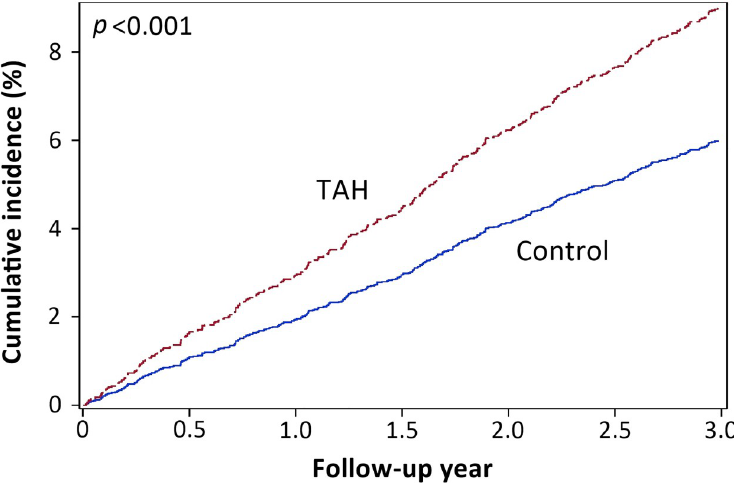
Fig 2. Cumulative incidence of fracture events using Kaplan–Meier estimator. Thiazide-assssociated hyponatremia (TAH) patients had increased fracture risk compared to matched comparison patients (log rank p < 0.001).